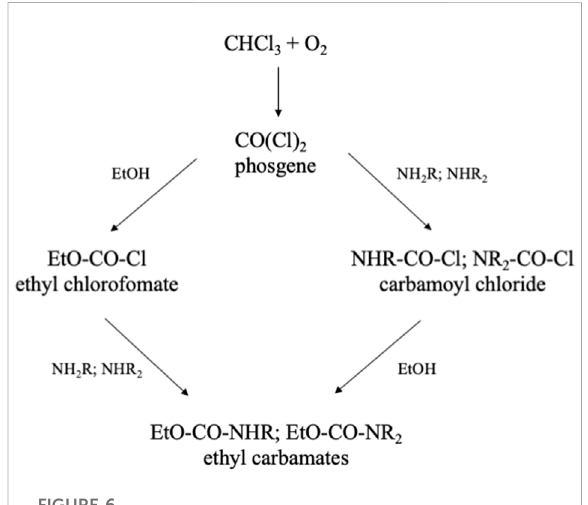
FIGURE 6 Formation of ethyl chloroformate in chloroform and possible resulting adducts (Siek et al., 1977; Cone et al., 1982; Maudens et al.,